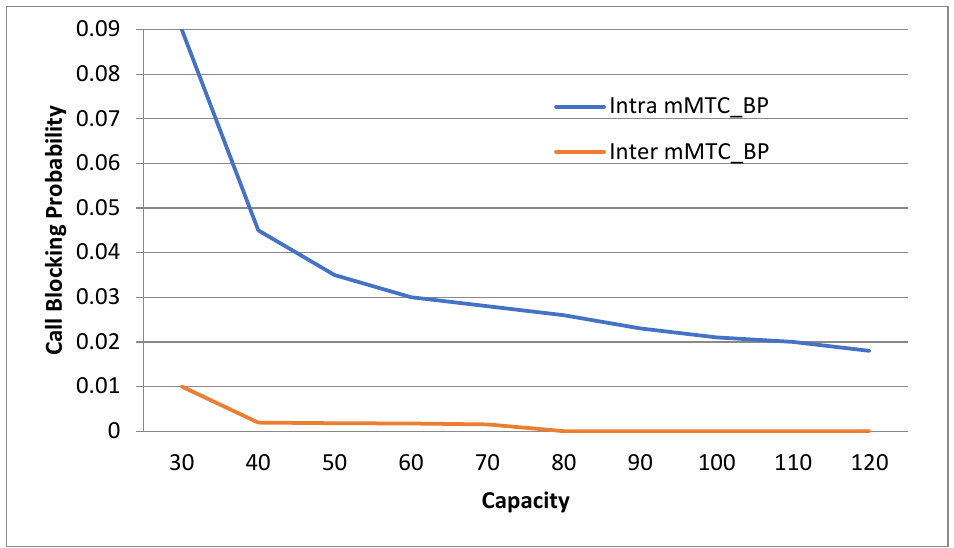
Figure 3 . Call Blocking Probability of mMTC Intra and Inter Slice .